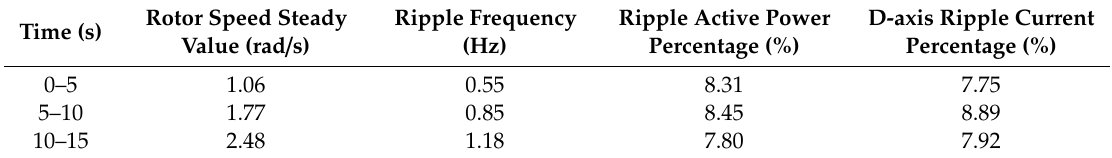
Table 2. Ripple composition of grid connection point under variable wind speed.